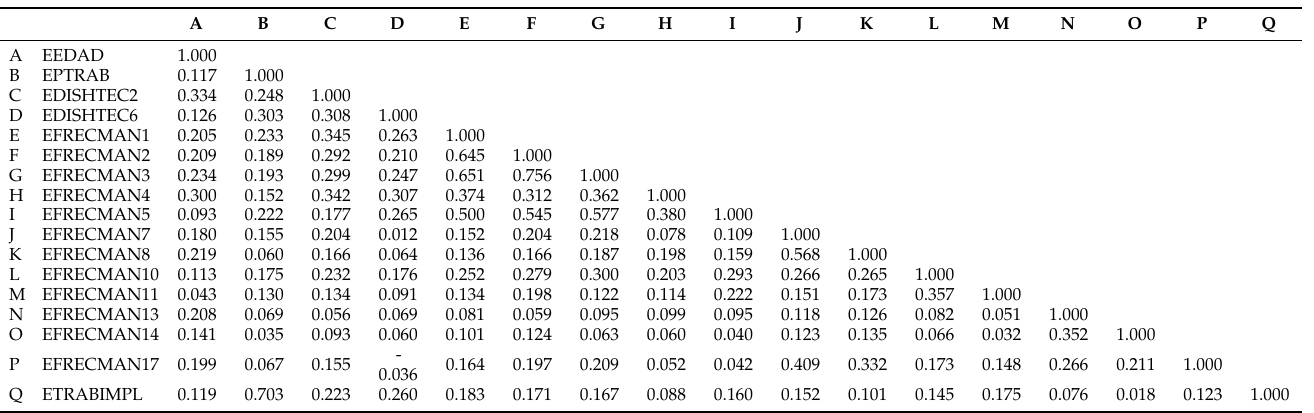
Table A1. Correlation of the observed